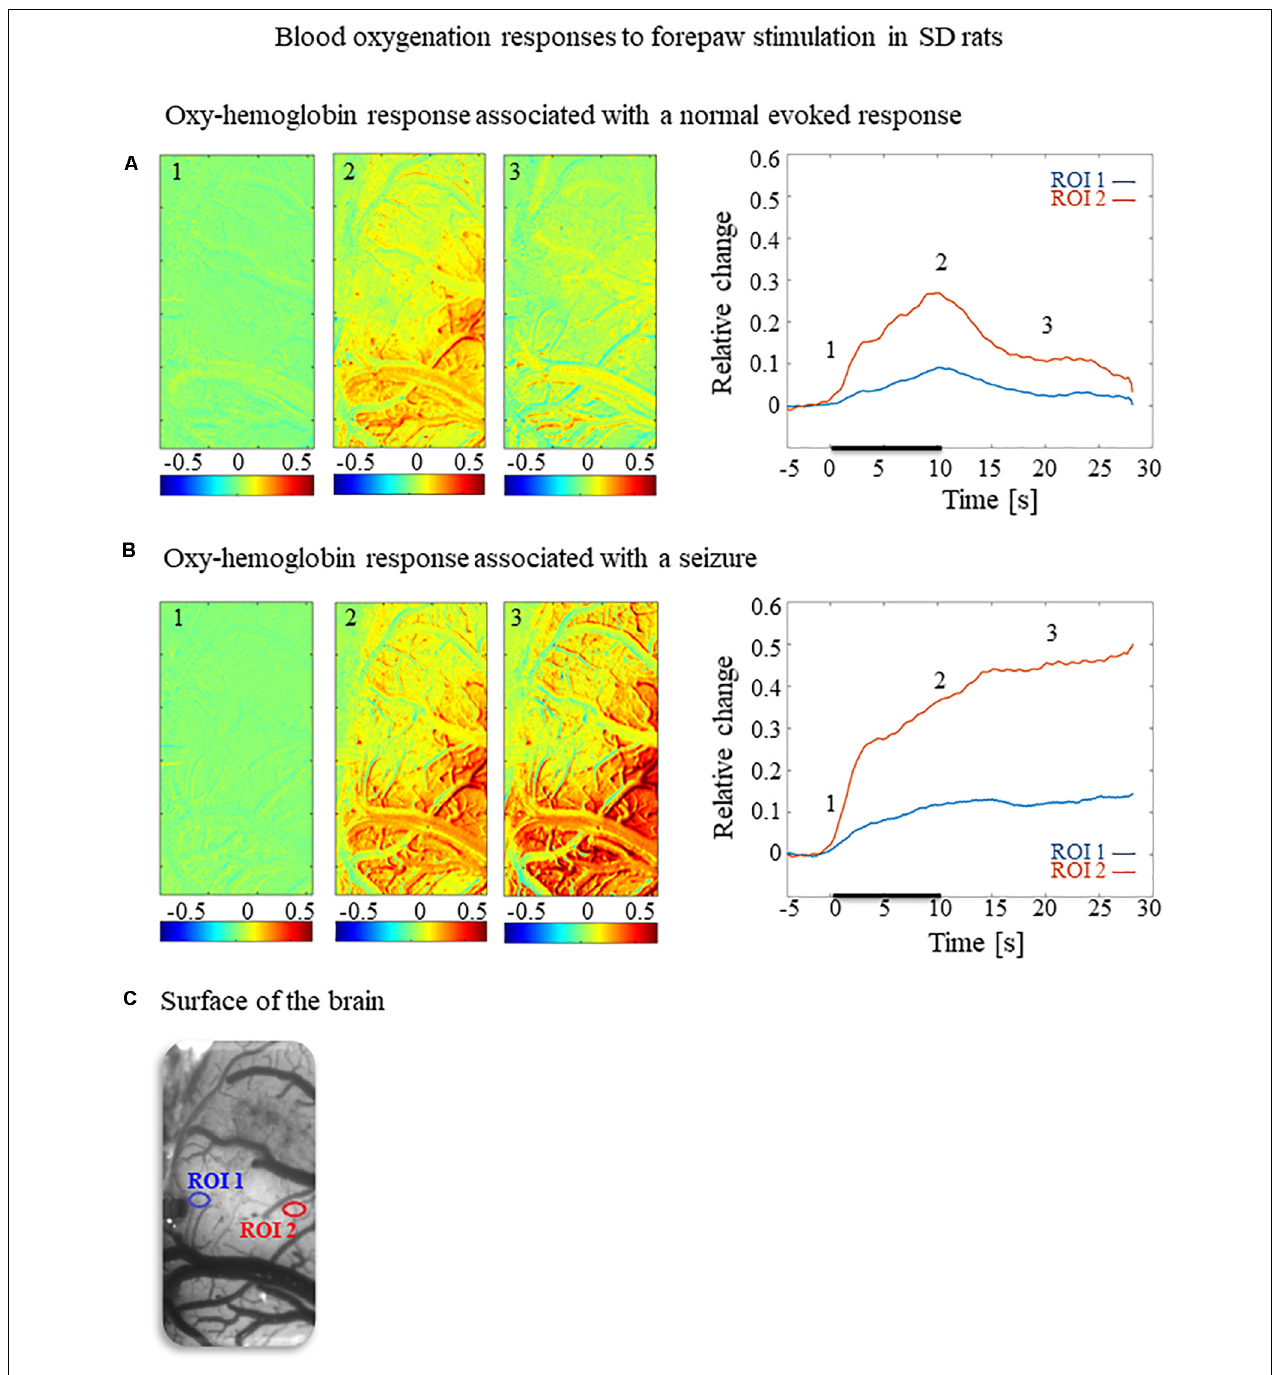
FIGURE 2 | Cerebral blood oxygenation responses evoked by forepaw stimulation. (A) Cerebral blood oxygenation response evoked by stimulation of the contralateral forepaw. To the left, the spatial responses before (the 1 s before stimulus onset), during (9–10 s following stimulus onset), and after (9–10 s following the cessation of the stimulus) the 10 s-long forepaw stimulation period. The reference for obtaining these responses was imaged between 3 and 1 seconds before stimulus onset. Note that positive responses are indicated in indexed yellow and red colors, representing increases in blood oxygenation. To the right are two time-courses presenting the corresponding temporal responses from two regions (blue and red ROIs in panel C) within the activated area. The stimulation period between 0 and 10 seconds is marked by a dark bar. (B) Maps of the blood oxygenation changes during a response that evoked a seizure, from before, during, and after the 10 s-long forepaw stimulation period (exact time periods are as in A). To the right are two time-courses presenting the corresponding temporal responses from two regions (blue and red ROIs in panel C) within the activated area. (C) The imaged cortical surface with the two ROIs used for sampling the time-courses presented in A and